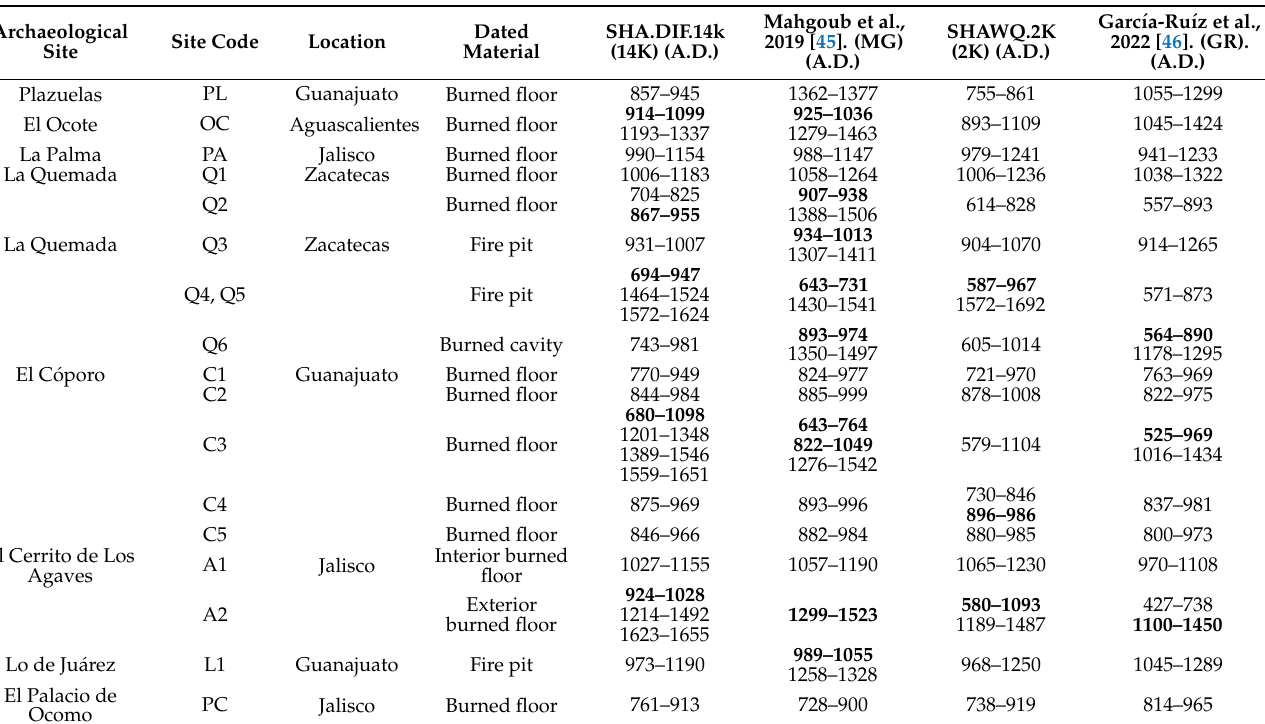
Table 2. Reappraisal of archaeomagnetic age intervals using global geomagnetic models and local reference curves (see text for more